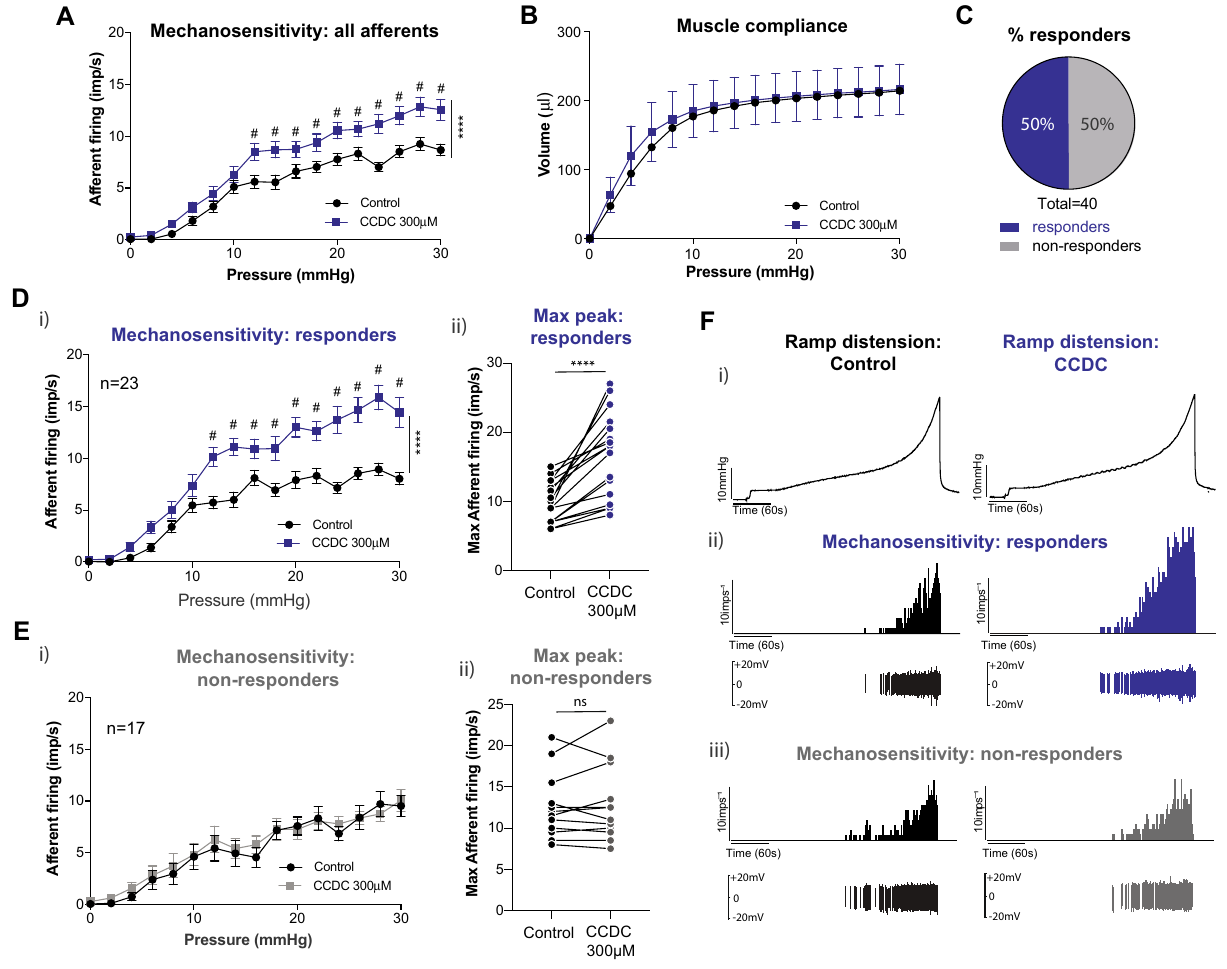
Figure 2. The synthetic TGR5 agonist CCDC enhances bladder afferent mechanosensitivity. ( A ) Afferent firing was recorded in response to graded bladder distension in an ex vivo preparation, comparing responses in the presence of saline (control) or the synthetic TGR5 agonist CCDC. Application of CCDC (300 µM) caused a significant increase in the overall afferent firing rate (impulses per second; imp/s) at distension pressures at and above 12 mmHg (n = 40 single units from N = 4 mice; **** P < 0.0001, and # P < 0.05 at individual distension pressures). ( B ) No differences were observed in the pressure to volume relationship between saline and CCDC (ns, P > 0.05). ( C ) Of the 40 mechanosensitive bladder afferents recorded, 50% (20 out of 40) displayed enhanced responses to distension after CCDC (responders), whilst 50% (20 out of 40) were unchanged. ( D ) CCDC-responsive afferents (n = 20) demonstrated a significant increase in mechanosensitivity following CCDC application. ( i ) Responders showed significantly increased mechanosensitivity to distension at pressures at and above 12 mmHg (**** P < 0.0001). ( ii ) The maximum peak of afferent firing with CCDC was significantly higher compared with saline (**** P < 0.0001). ( E ) CCDC-unresponsive mechanosensitive afferents (non-responders; n = 20) showed no difference in mechanosensitivity between saline and CCDC, with ( i ) no difference in imp/s at any distension pressure (ns, P > 0.05) and ( ii ) no change observed in the maximum imp/s to bladder distension (ns, P > 0.05). ( F ) ( i ) Example experimental traces showing the graded increase in pressure that occurs with increasing volume over time with saline, followed by CCDC. ( ii ) Graded increases in afferent firing in response to bladder distension, with a visible increase in imp/s following administration of CCDC (100 µM). ( iii ) Graded increase in afferent firing in response to bladder distension, with no change in response between saline and CCDC administrations. Data are represented as mean ± SEM ( A , B , Di , Ei ), percentage of afferents ( C ), or maximum imp/s ( Dii ) and Eii ). ‘Responders’ were defined by a greater than 25% increase in afferent firing ( C , D , E ). P values above are based on two-way ANOVA ( A , B , Di , Ei ), with subsequent Sidak’s post hoc test significance at individual data points indicated ( A , Di , # represents significance of at least P < 0.05), or Wilcoxon matched-pairs signed rank test ( Dii , Eii